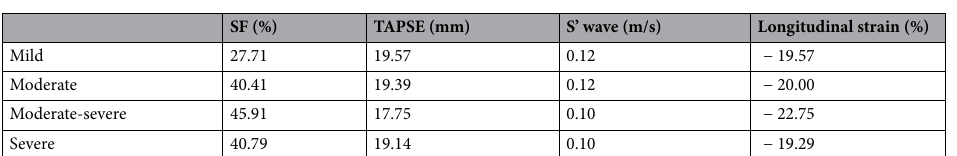
Table 3. TAPSE, Sl, SF, and S’ wave according to TI grade. SF, shortening fraction; TAPSE, tricuspid annular plane systolic